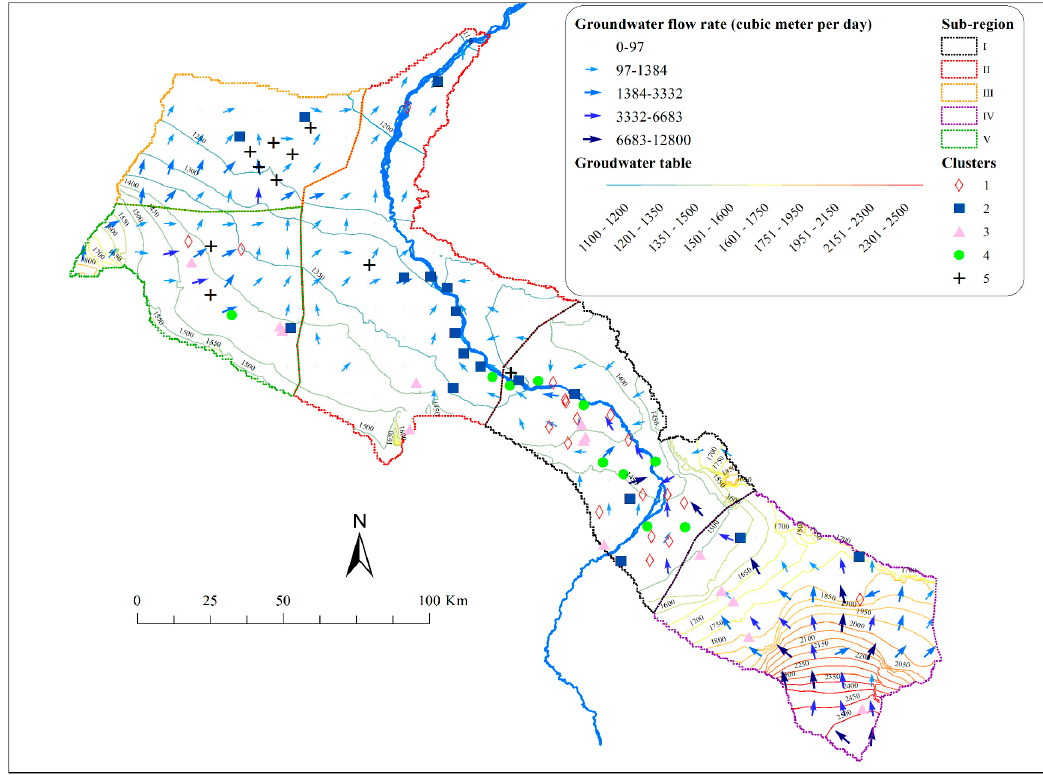
Figure 7. Regionalization of the groundwater chemistry. Based on the GMM clustering, the study area can be divided into five sub-regions.